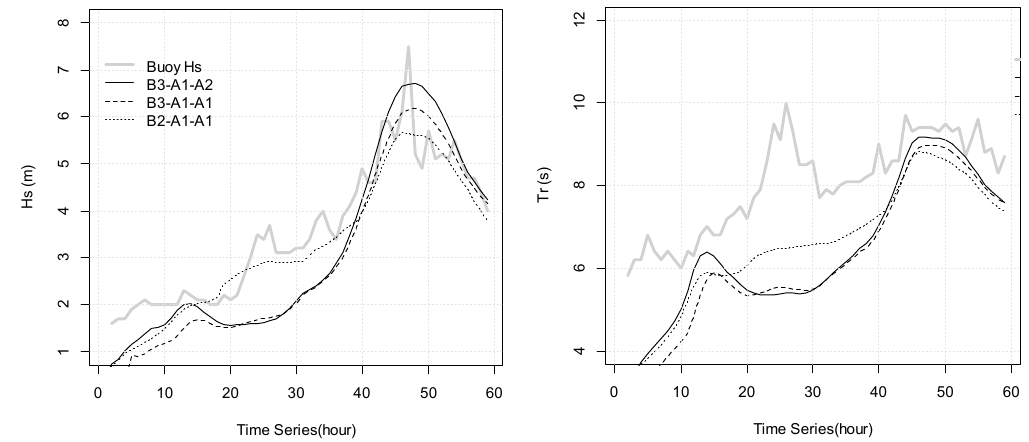
Figure A4. Comparison of typhoon waves induced by Typhoon Vicente (08-2012) at buoy QF301: the standard H10 is indexed as B2-A1-A1, the model with varying parameter b without an asymmetric typhoon structure is indexed as B3-A1-A1, and MH10 is indexed as B3-A1-A2.